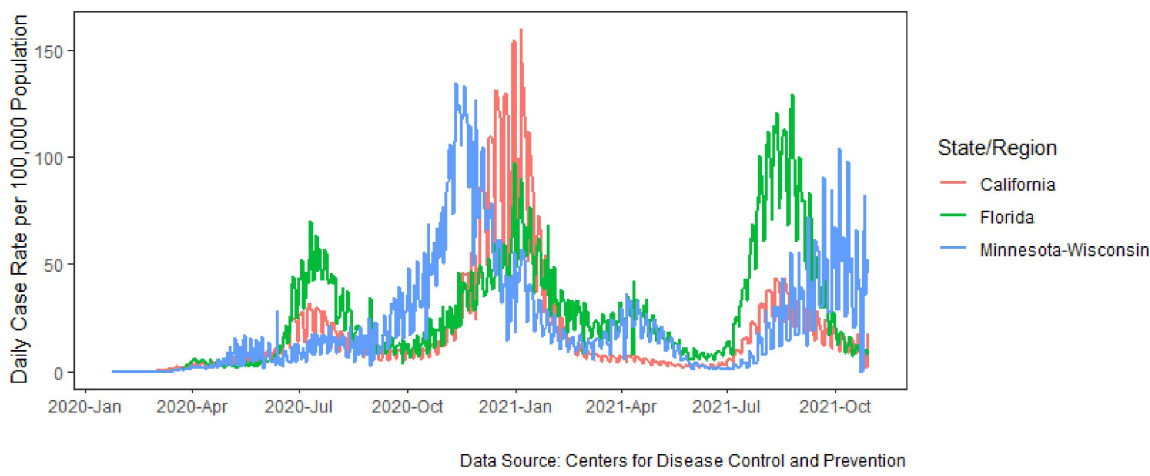
Fig 2. Daily case rate per 100,000 population in Florida, California, and the combined region of